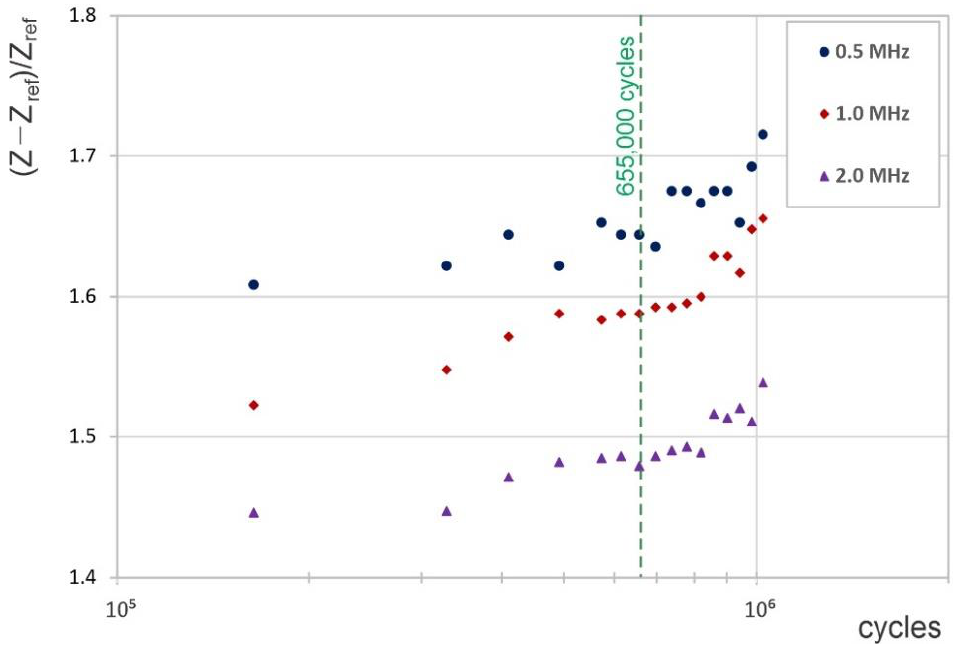
Figure 14. The relative change in impedance with the number of cycles, as experimentally measured. Using the translated crack growth curve from Figure 13, the relative change in the coil’s impedance is shown with respect to the crack size in Figure 15. The semi-logarithmic graphic representation displays the relative impedance variations with the crack length. These have a linear behavior, on the semi-log scale, with the crack length all the way to the end of the test, i.e., at a crack length of 15.0 mm. As seen in Figure 15, a lower driving frequency (0.5 MHz) resulted in better sensitivity to crack length than higher frequencies. However, it was observed that data scatter increases with decreasing frequency, and consequently, the optimal test procedure should be selected by balancing sensitivity and scatter. Although the two coils were not perfectly balanced in the experimental investigation, the behavior of the relative impedance change was similar to that found through the numerical simulations and displayed in Figure